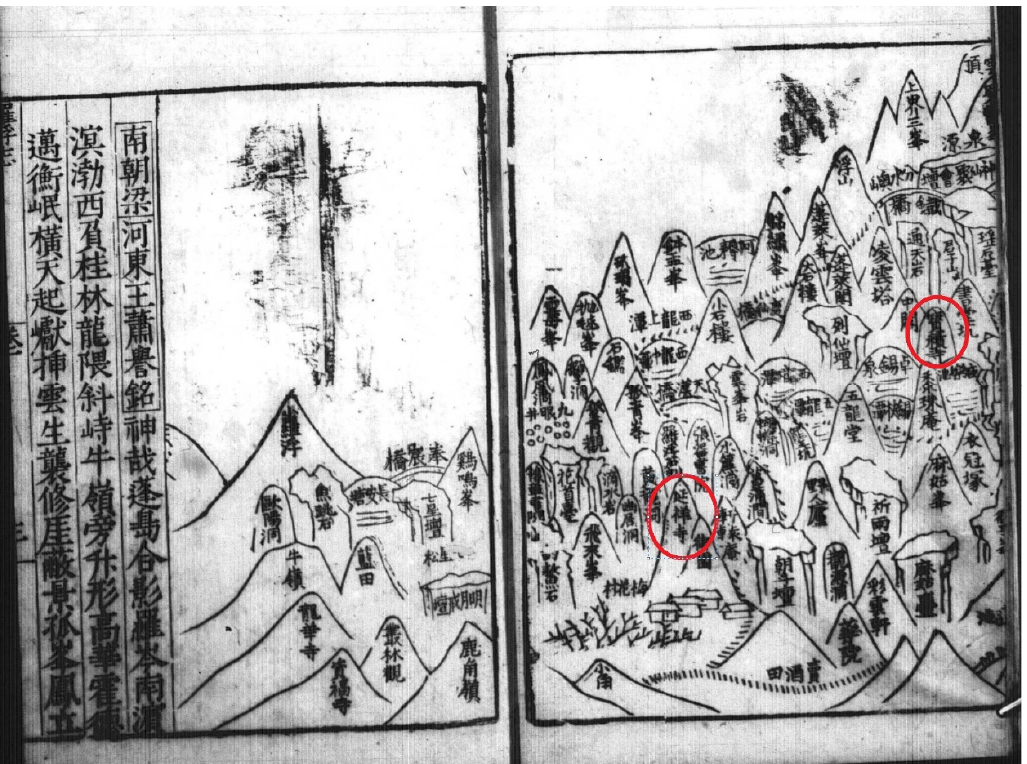
Figure 11. The Yanxiang Si (left) and Baoji Si in the panorama in Huang Zuo’s gazetteer, 1557. Woodblock print. After Huang Zuo, Luofu shan zhi , 1.1b-3a.